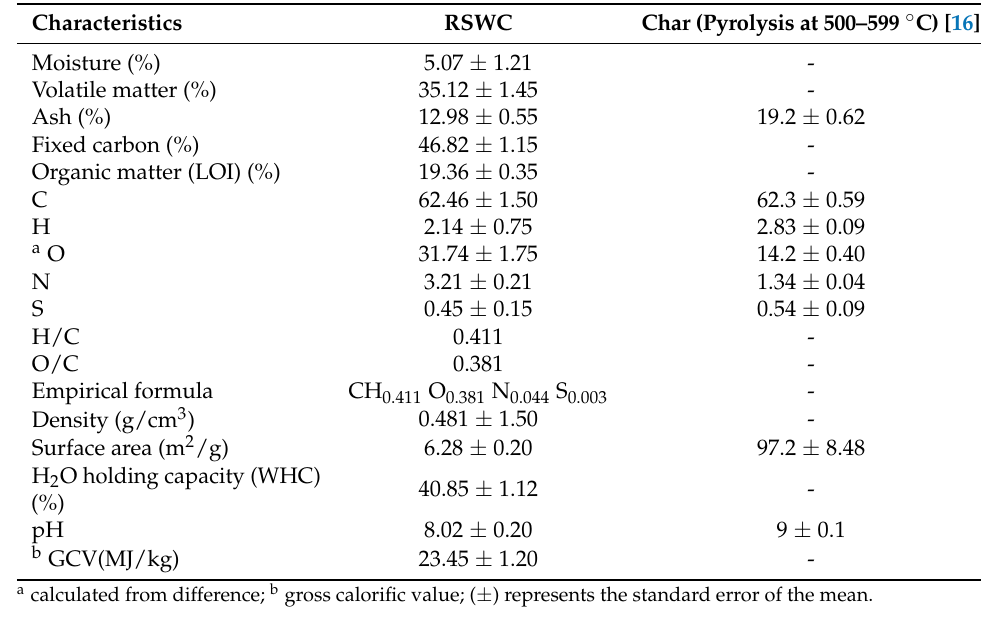
Table 5. Physical and chemical characteristics of the char obtained by pyrolysis without catalyst, at a temperature of 550 ◦ C, heating rate of 75 ◦ C/min, 0.5 mm biomass particle size and a carrier gas flow rate of 80 mL/min.